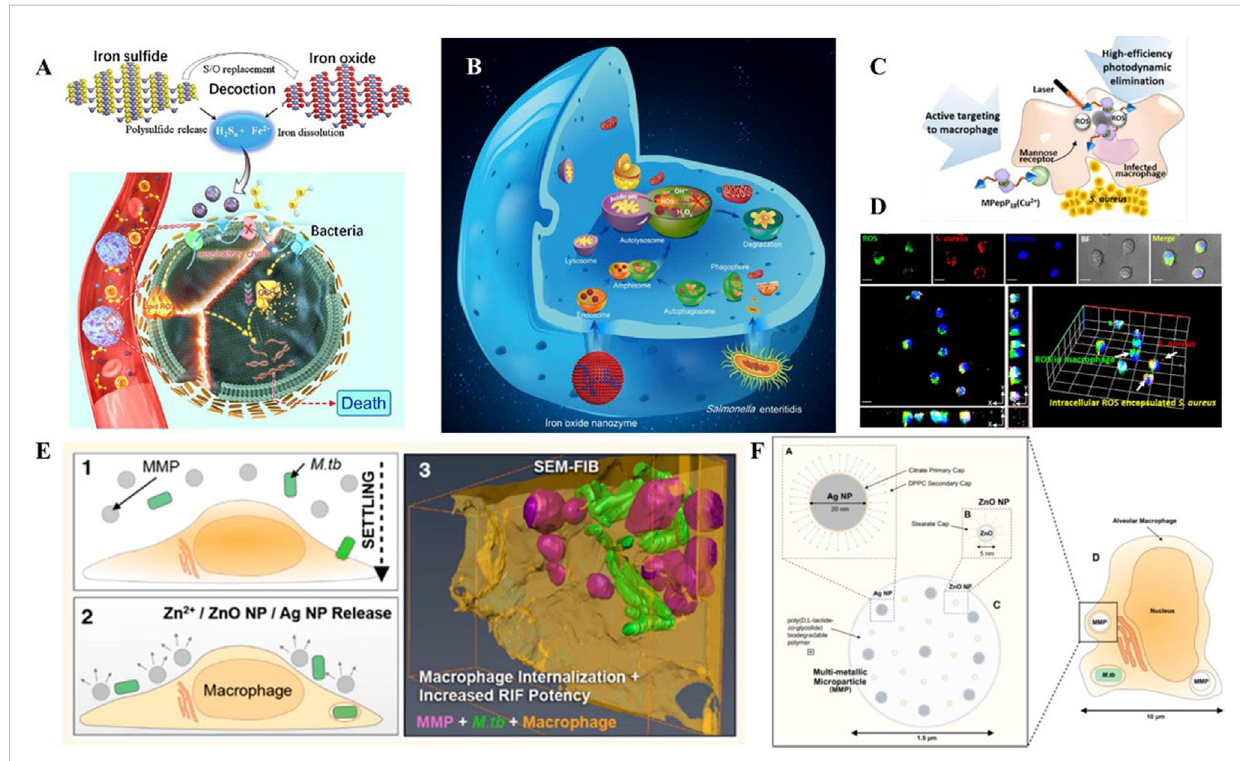
FIGURE 5 (A) Schematic illustration of the bioactive nanoparticles with collaborative bactericidal function depends on both ferrous iron and polysul fi de. (B) Schematic illustration of the bacteriostatic effects of IONzymes with enzymes-like activity and mechanism responsible for the antibacterial activity. (C) Schematic illustration of the peptide-chlorophyll-based photodynamic therapy (PDT) agents to enhance the PDT effect and active targeting property to eliminate intracellular infections. (D) Confocal images of intracellular ROS production by MPepP 18 (Cu 2+ ) in S. aureus infected macrophage. (E) Schematic illustration of the biodegradable multi-metallic particles (MMPs), containing Ag NPs and ZnO NPs, and its pulmonary delivery of anti- tuberculous drugs to the endosomal system of M.tb -infected macrophages. (F) MMPs embedded with Ag NPs and ZnO NPs within the endosome of an M.tb -infected alveolar macrophage. Reproduced with permission from Shen et al. (2020); Shi et al. (2018); Cai et al. (2018) (Copyright 2018 American Chemical Society) and Ellis et al.